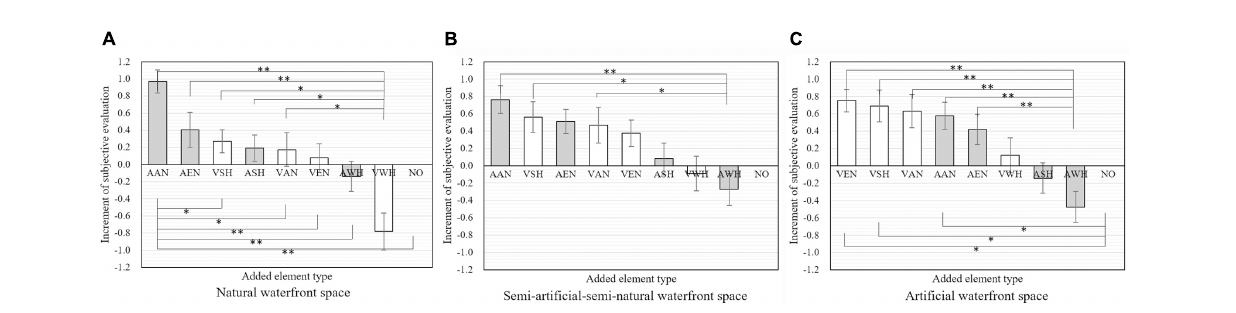
FIGURE9 Increment of subjective evaluation of restoration after adding different audio and visual elements in natural waterfront space (A) , semi-artificial-semi-natural waterfront space (B) , artificial waterfront space (C) . AEN, auditory elements of environment-nature, AAN, auditory elements of animal-nature; ASH, auditory elements of on-shore human activity; AWH, auditory elements of on-water human activity; VEN, visual elements of environment-nature; VAN, visual elements of animal-nature; VSH, visual elements of on-shore human activity; VWH, visual elements of on-water human activity; NO, no element added; color green, visual elements; color blue, auditory elements. (The error bars represent the standard errors on the averages: ± 1SE). Asterisks indicate statistically significant differences in mean scores (* p < 0.05; ** p <